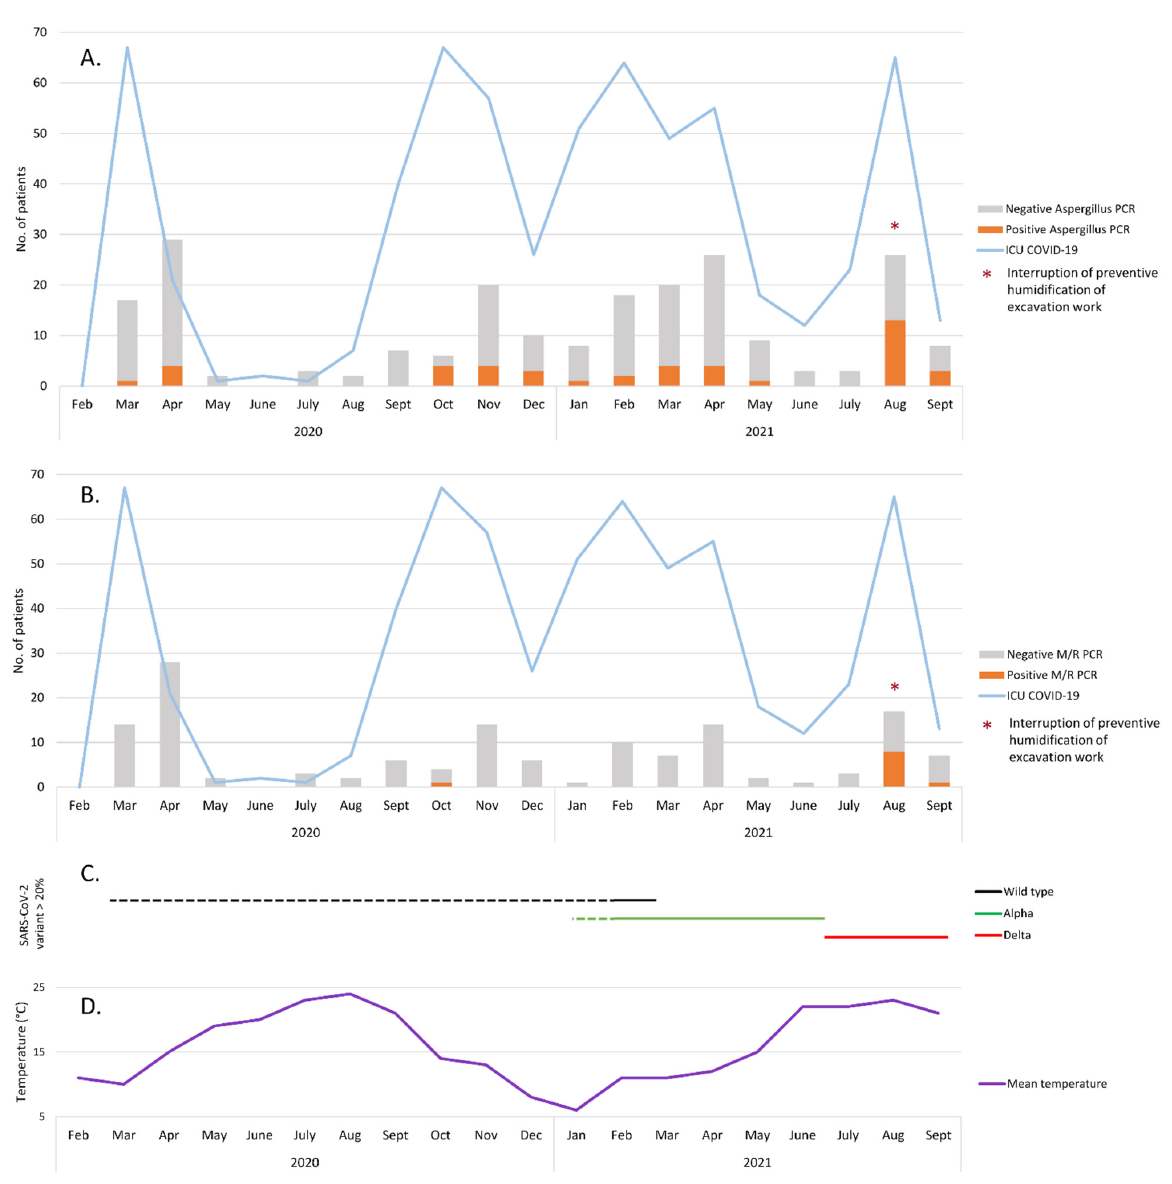
Figure 2. Number of COVID-19 patients hospitalised in ICU during the study period and results of respiratory sample screening for Aspergillus ( A ) or Mucorales ( B ). The dates used for individual patients were the date of the first positive SARS-CoV-2 PCR and the date of the first positive fungal PCR. If all fungal PCR were negative, the date used was the date of the first test. ( C ) SARS-CoV-2 variant circulation during the study period. Changes in the majority variants are represented by lines. Dotted lines are estimates. ( D ) Mean temperature (°C) in Toulouse during the study period [12].